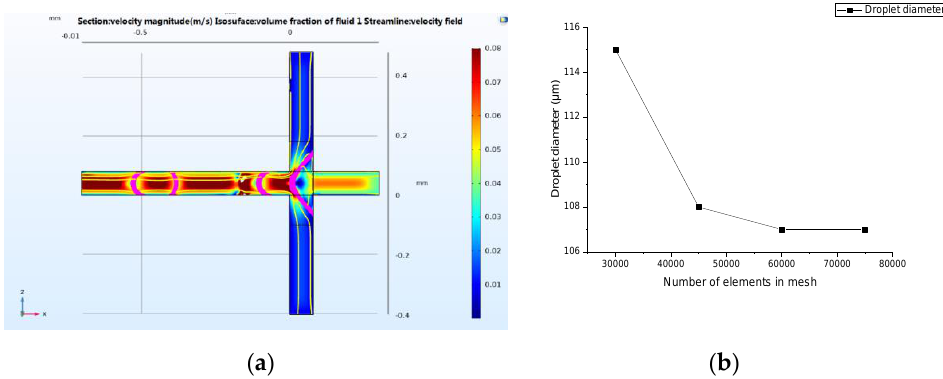
Figure 5. The COMSOL Multiphysics software interface showing a generation of droplet under set boundary conditions ( a ). Mesh refinement assay of the physical model ( b ).